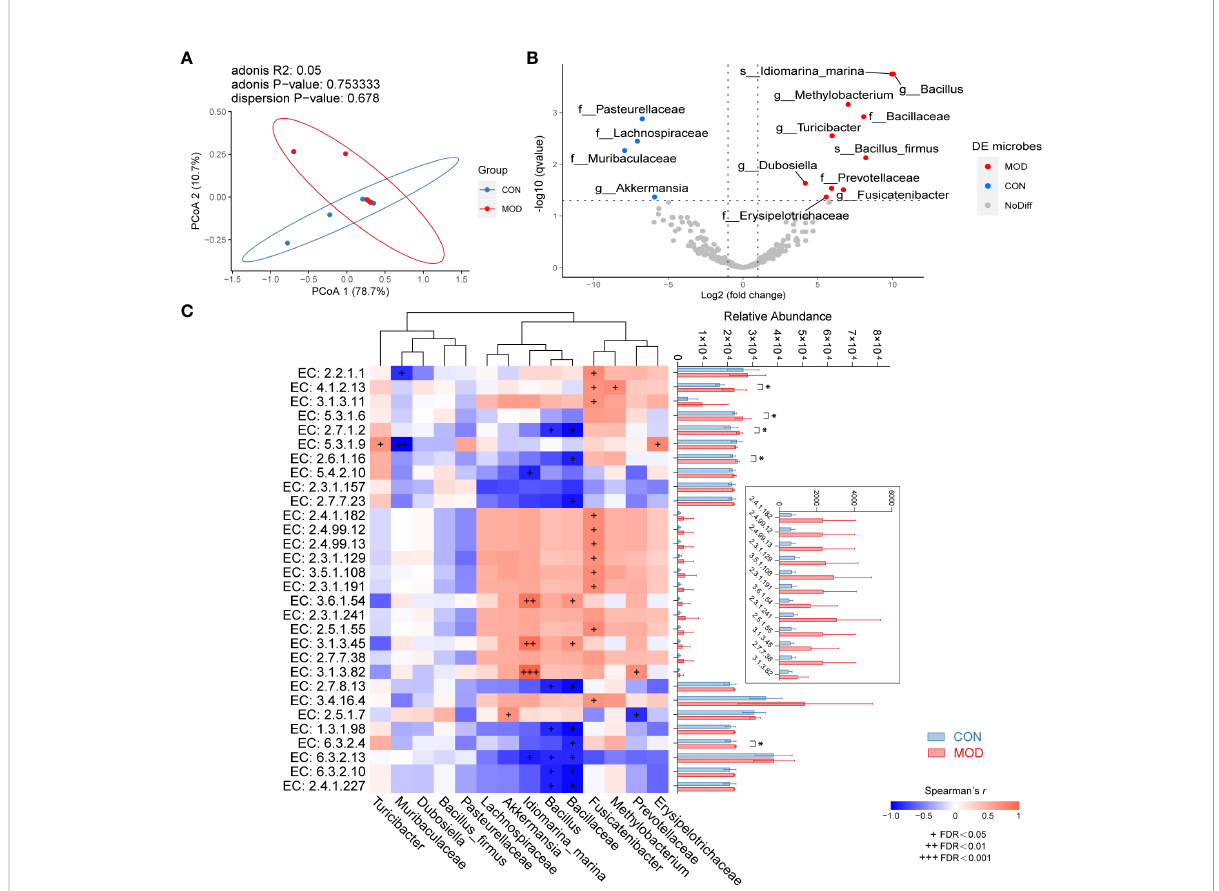
FIGURE 3 Microbial features of duodenum. (A) Weighted UniFrac PCoA with an adonis test. (B) Differential microbiome with DESeq2 analysis. The left dots (blue) indicate the microbiome enriched in control group; the right dots (red) are representative of the microbiome enriched in model group. (C) Spearman correlations of differential microbiome and predicted functional enzymes (Spearman ’ s r > 0.6 with + FDR < 0.05, ++ FDR < 0.01 or +++ FDR < 0.001 represent signi fi cant). The right side indicates multiple comparison of relative abundance of enzymes with Fisher ’ s LSD (mean ± SEM, * p < 0.05 represent signi fi cant) ( n = 5